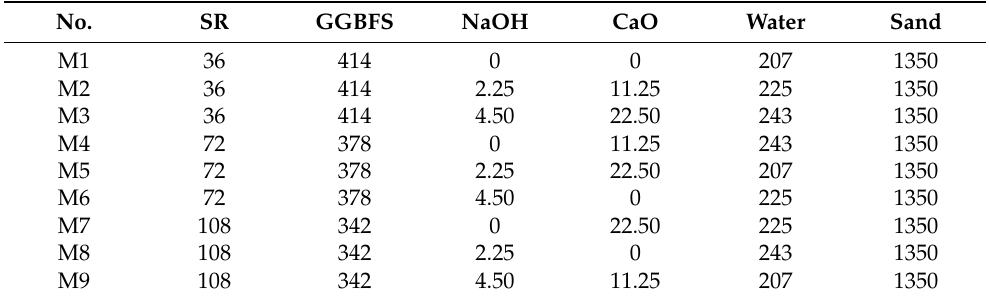
Table 3. Group I, mixing proportions of mortars according to the experimental design in Table 2 (g).